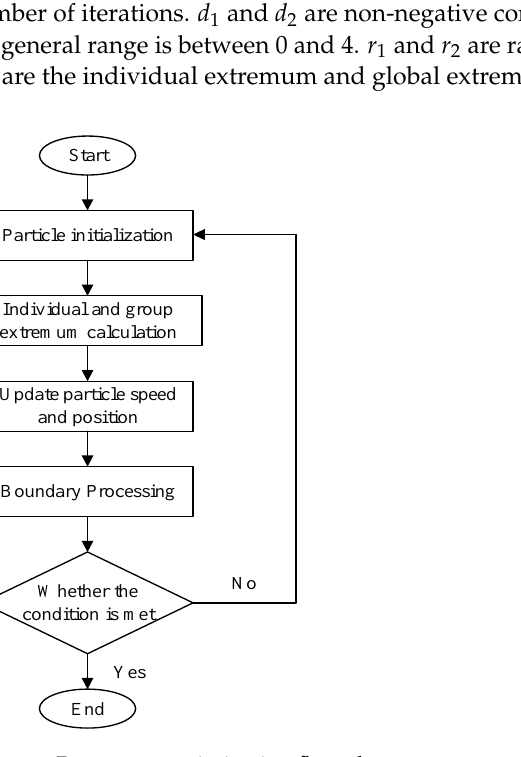
Figure 6. Parameter optimization flow chart.